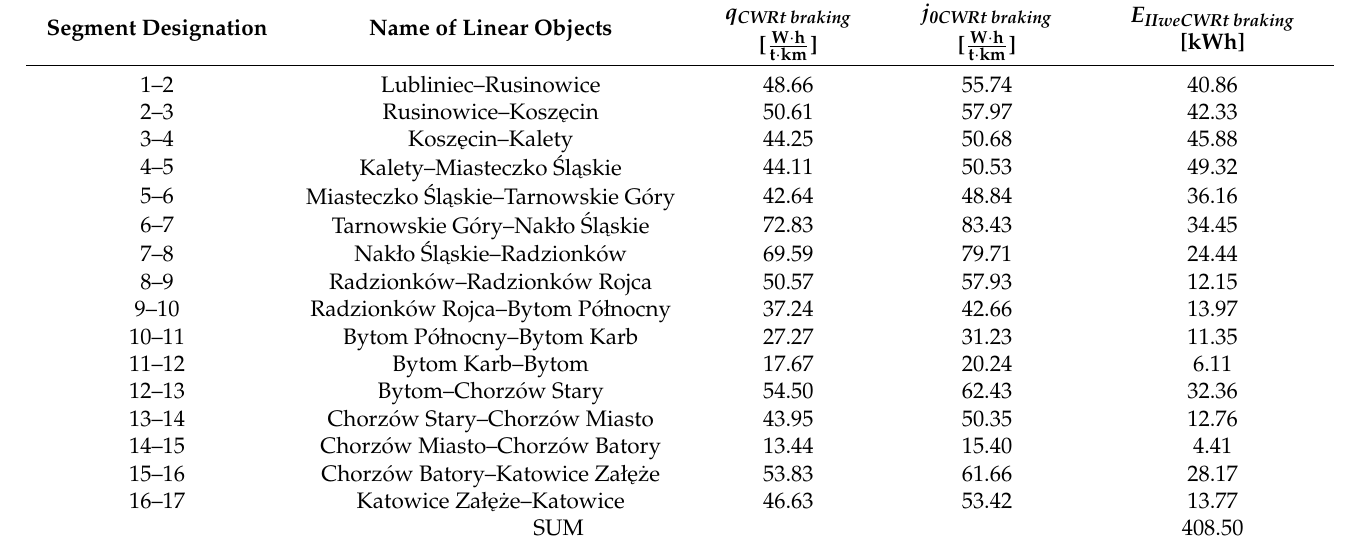
Table 4. Calculated electricity consumption values q CWRt braking , j 0CWRt braking and E IIweCWRt braking (Variant II, the new approach during braking on continuous welded rail